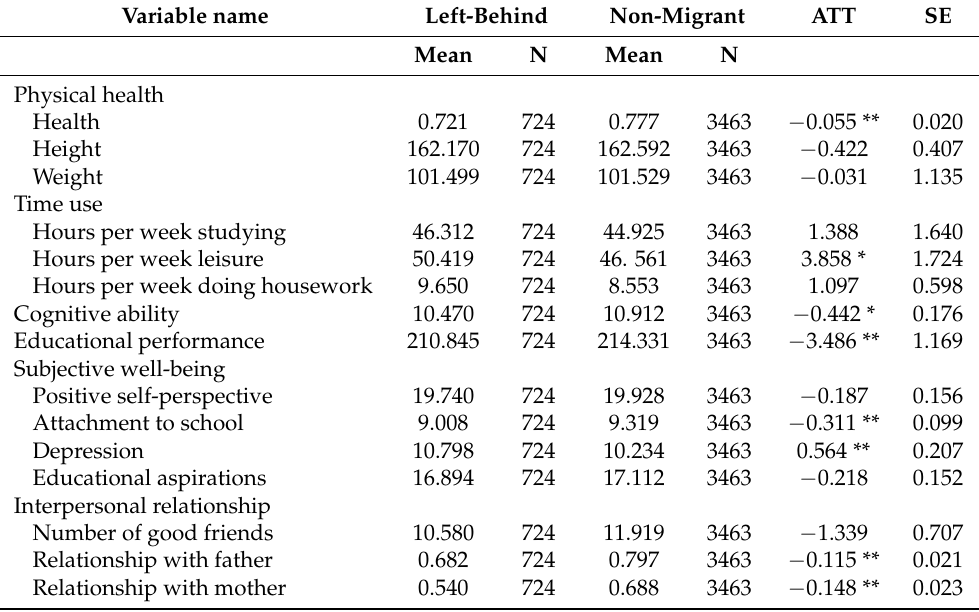
Table 5. Estimates of the average treatment effects on the treated (left-behind children) with non- migrant children as the control